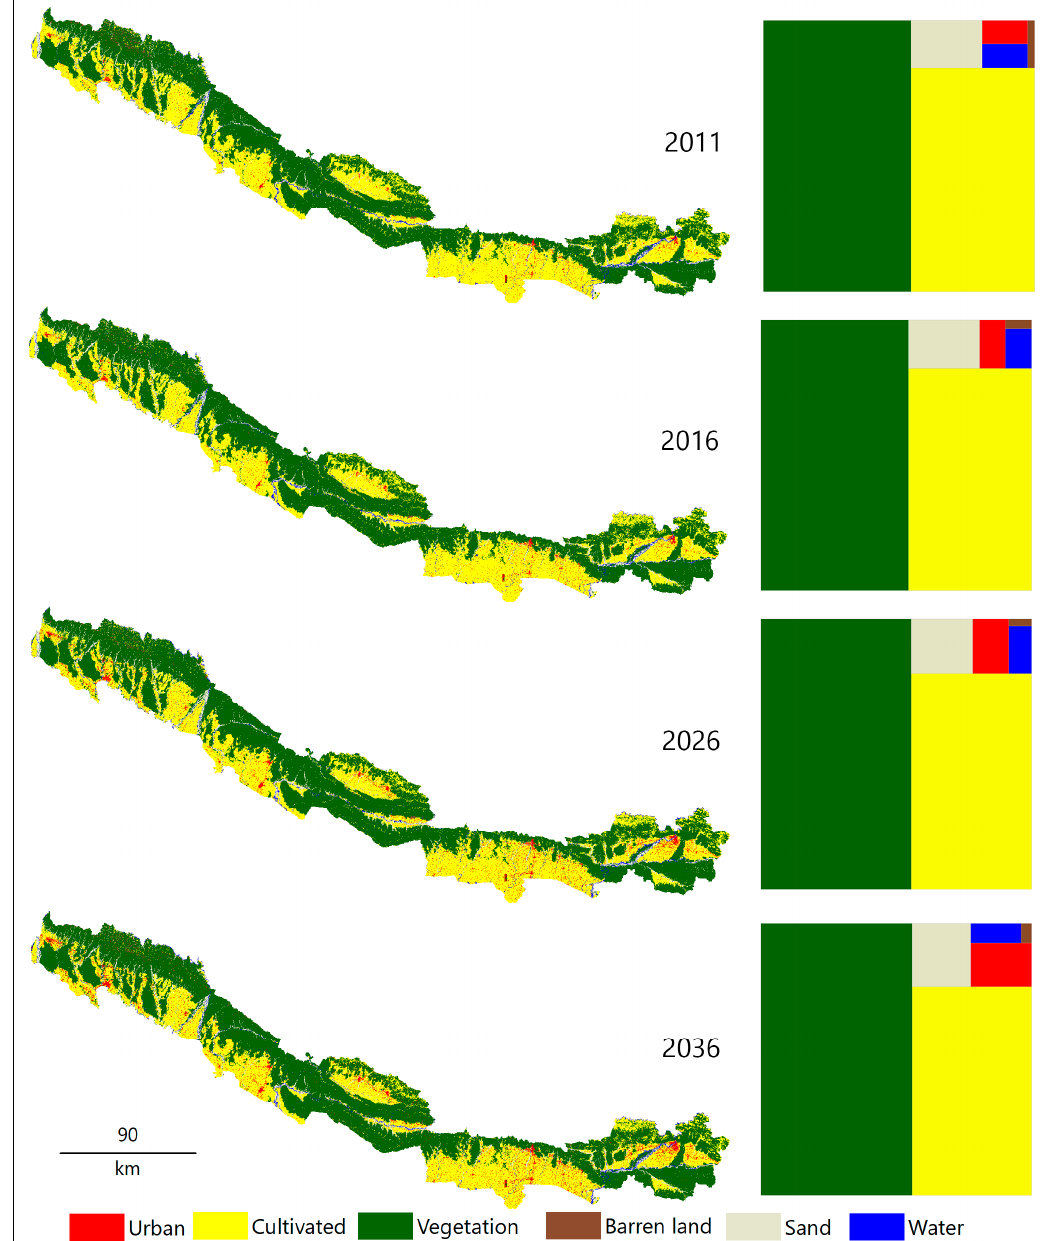
Figure 7. Land-cover maps from 1989 to 2036, western Tarai region. The sizes of the color-coded boxes at the right are indicative of the relative areas of each land-cover class.